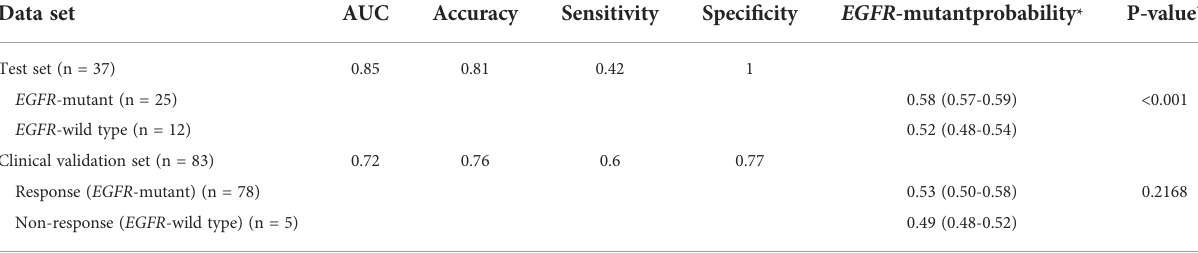
TABLE 4 Performance of multimodal ef fi cientNet-b1 for lung (MENL) in the clinical validation set. Data set AUC